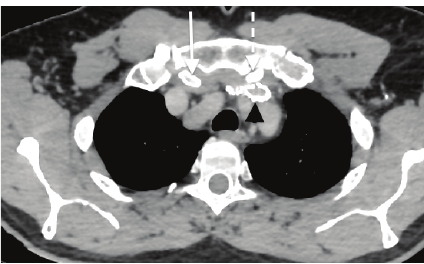
Figure 2: Axial view of large osteophytic projection arising from the posterior surface of the left clavicular head impinging the left subclavian stent.